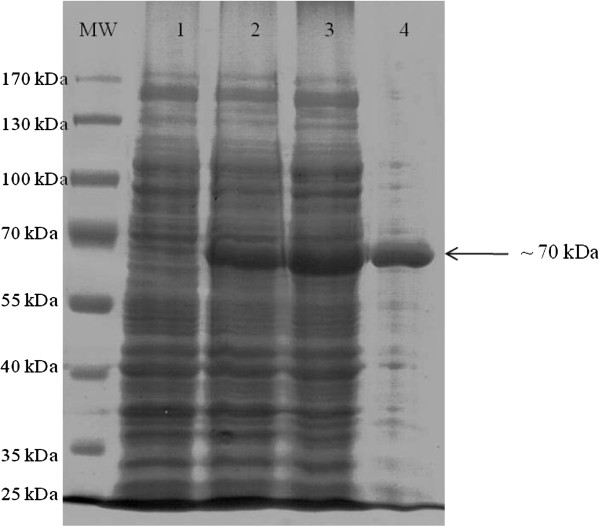
Purified recombinant PGM protein. Lane MW: PageRulerTM Prestained Protein Ladder; Lane 1: Non-induced cell pellet; Lane 2: Induced cell pellet; Lane 3: Induced cell supernatant; Lane 4: Purified protein; Arrow indicates the recombinant PGM protein (~70 kD).